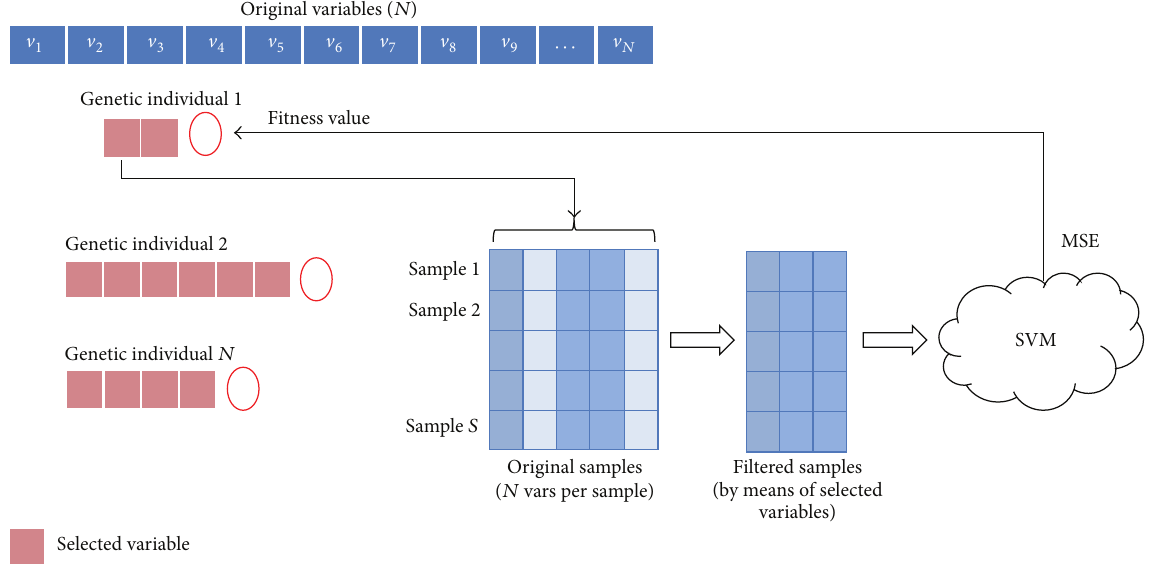
Figure 5: Evaluation of the genetic